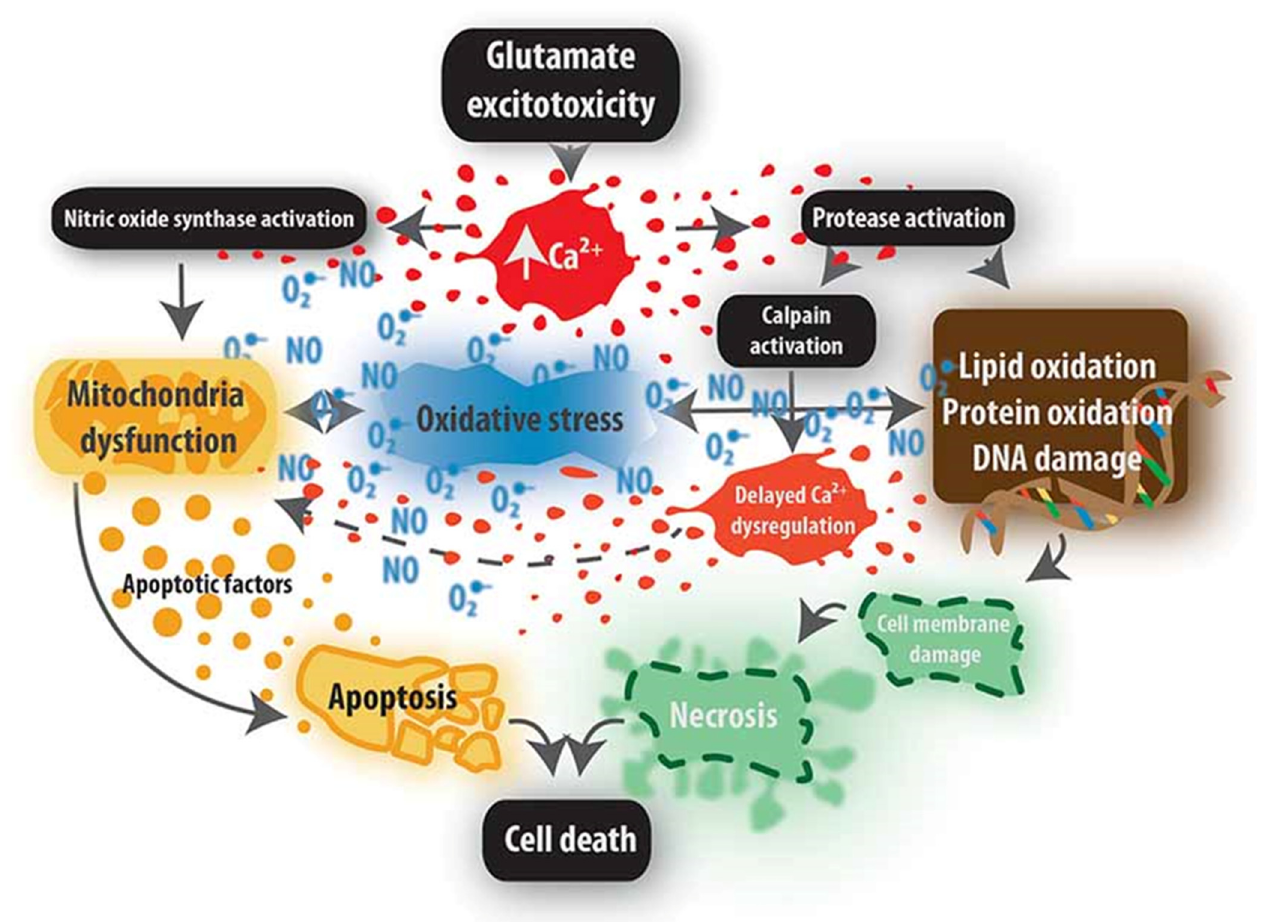
Figure 1. This figure is Reproduced from a Frontiers in Cellular Neuroscience by Belov Kirdajova, D., J. Kriska, J. Tureckova and M. Anderova. Ischemia-Triggered Glutamate Excitotoxicity From the mitochondrial stress, elevated Ca 2+ with associated enzyme activation and cell death. Reprinted Perspective of Glial Cells. Front Cell Neurosci 2020 , 14 , 51. Doi: 10.3389/fncel.2020.00051 [68]. from Ref.